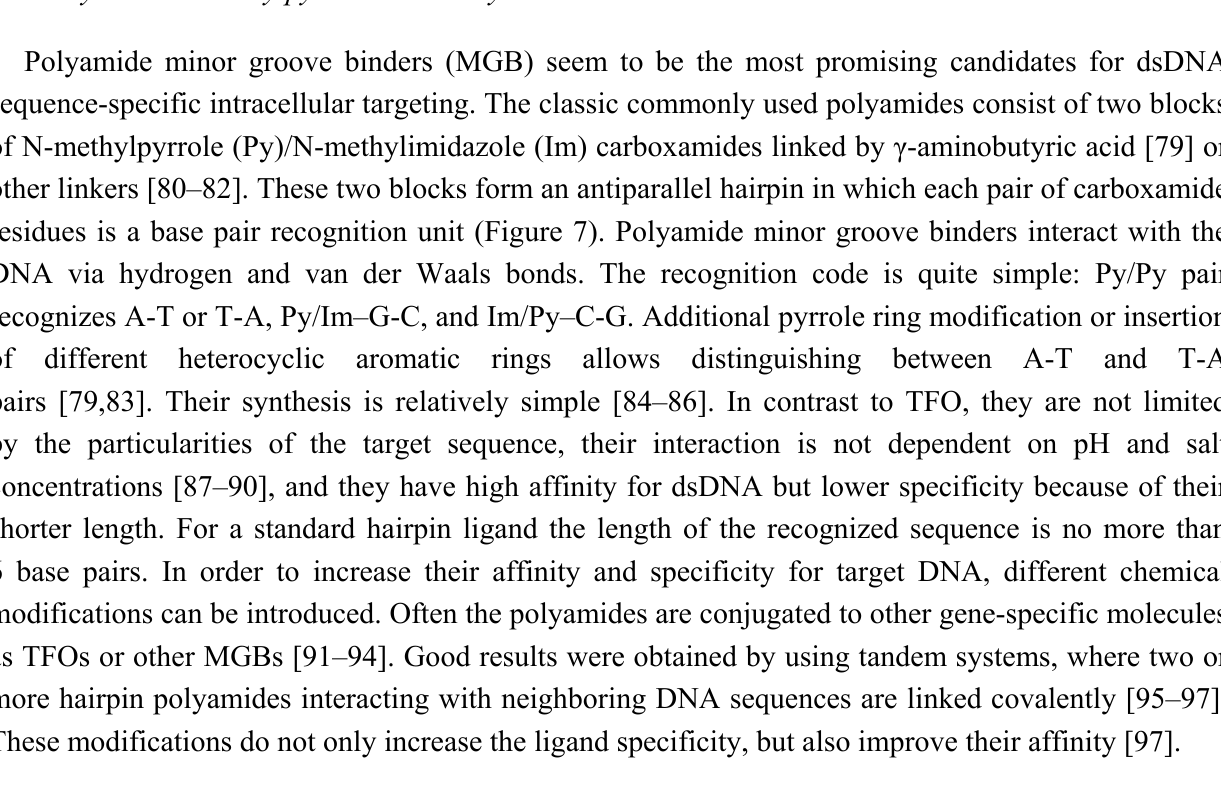
Figure 7. Structure of hairpin N-methylpyrrole/N-methylimidazole polyamides and code of DNA recognition upon their binding to DNA minor groove